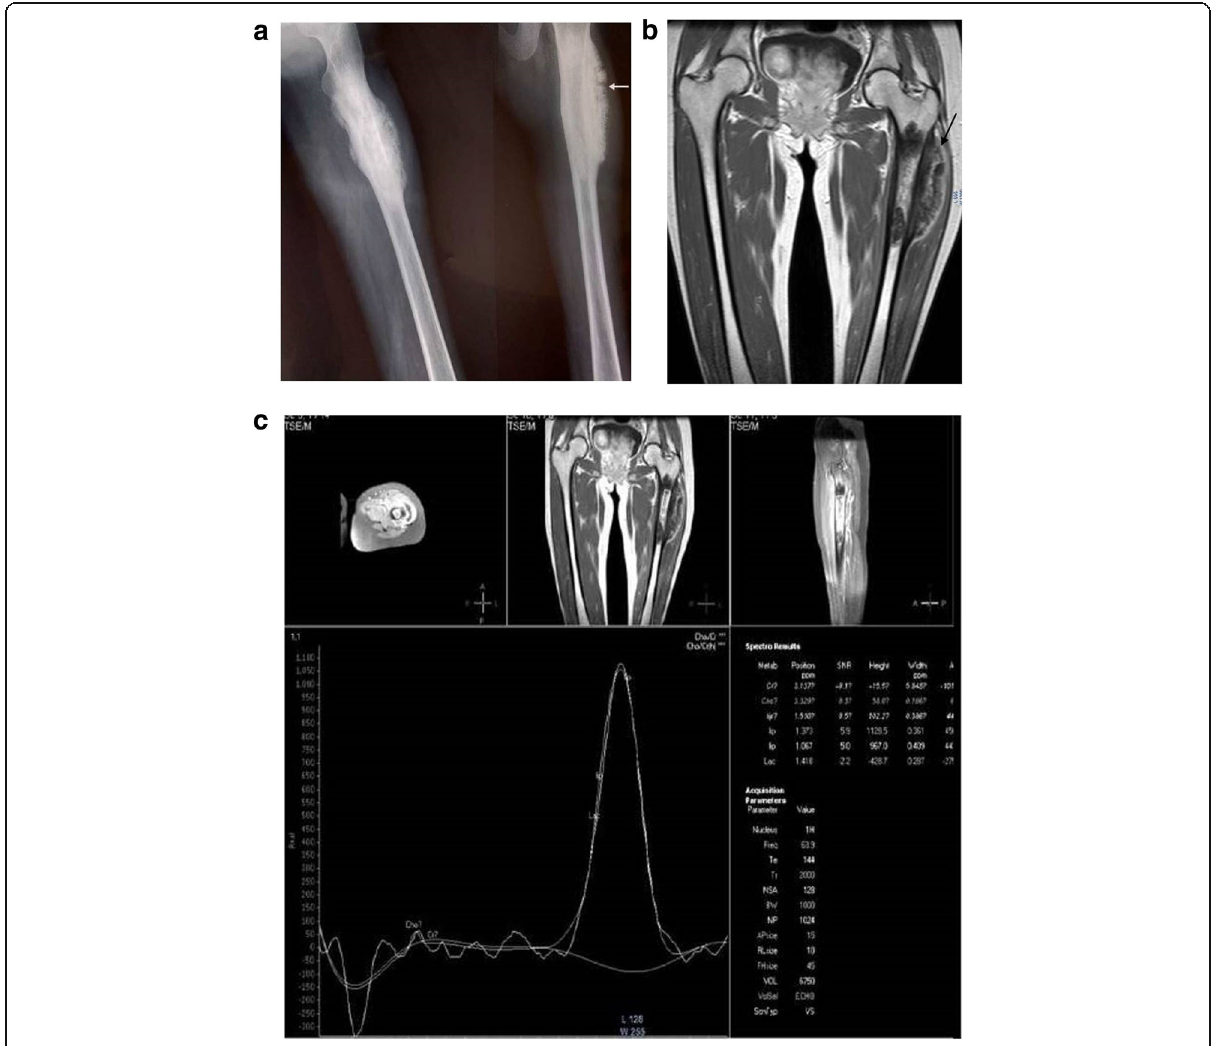
Fig. 6 A 17-year-old female patient with pain in the left thigh. a Radiograph showing a dense sclerotic lesion in the metaphysis of the left proximal femur with an apparent sun-burst type of periosteal reaction along the lateral aspect (arrow) and matrix ossification. The radiographic diagnosis was osteosarcoma. b Coronal T1-weighted post-contrast image shows metaphyseal lesion with a radiating type of periosteal reaction (arrow). Contrast enhancement is seen within the periosteal component. c MRS shows no discrete choline peak. A tall lipid lactate peak is noted. Histopathology was proven to be chronic